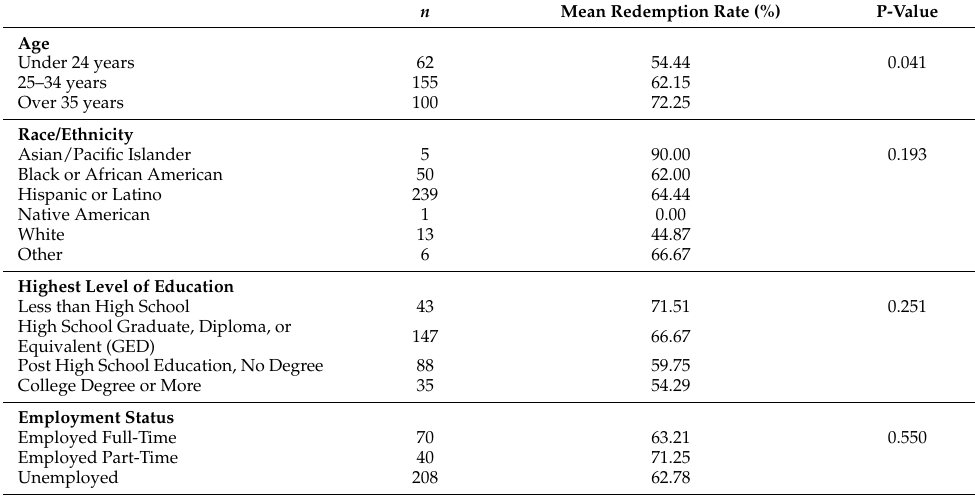
Table 1. Demographics and Redemption Rates for Survey Respondents.